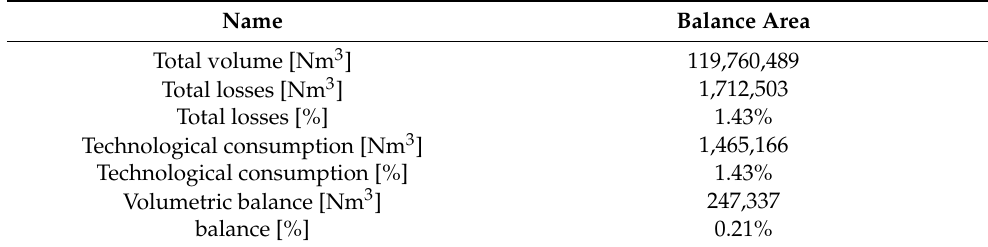
Table 3. Total losses and volumetric balance (source: authors based on the analysed